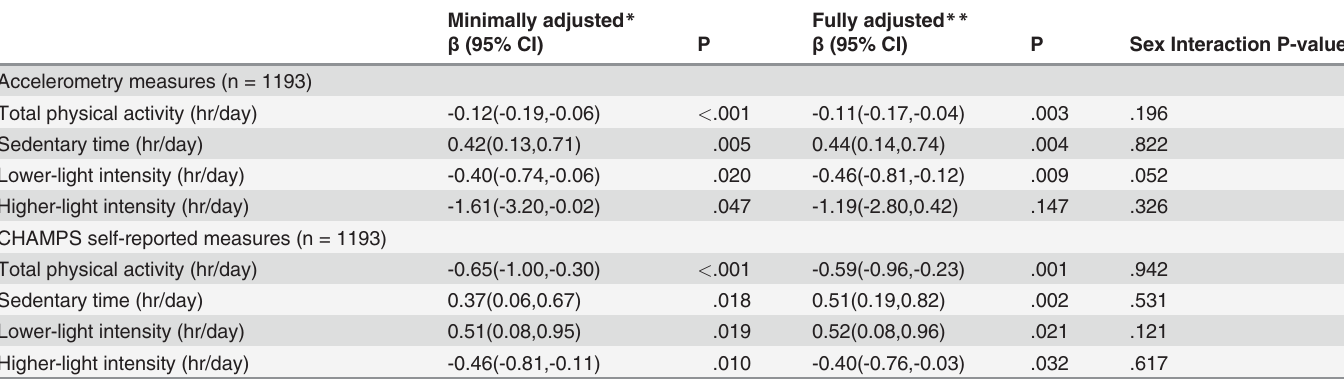
Table 2. Mean differences in body mass index (kg/m 2 ) per unit increase in physical activity and sedentary